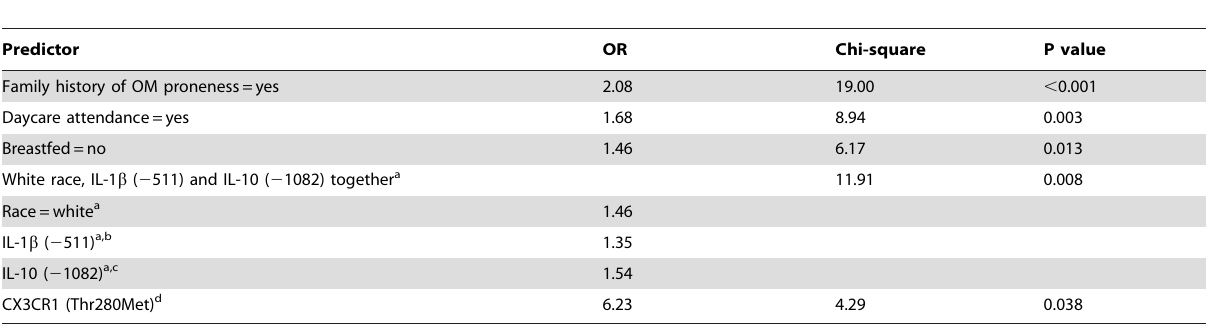
Table 3. Logistic regression model ( R 2 =0.12) to predict OM proneness in 653 children.